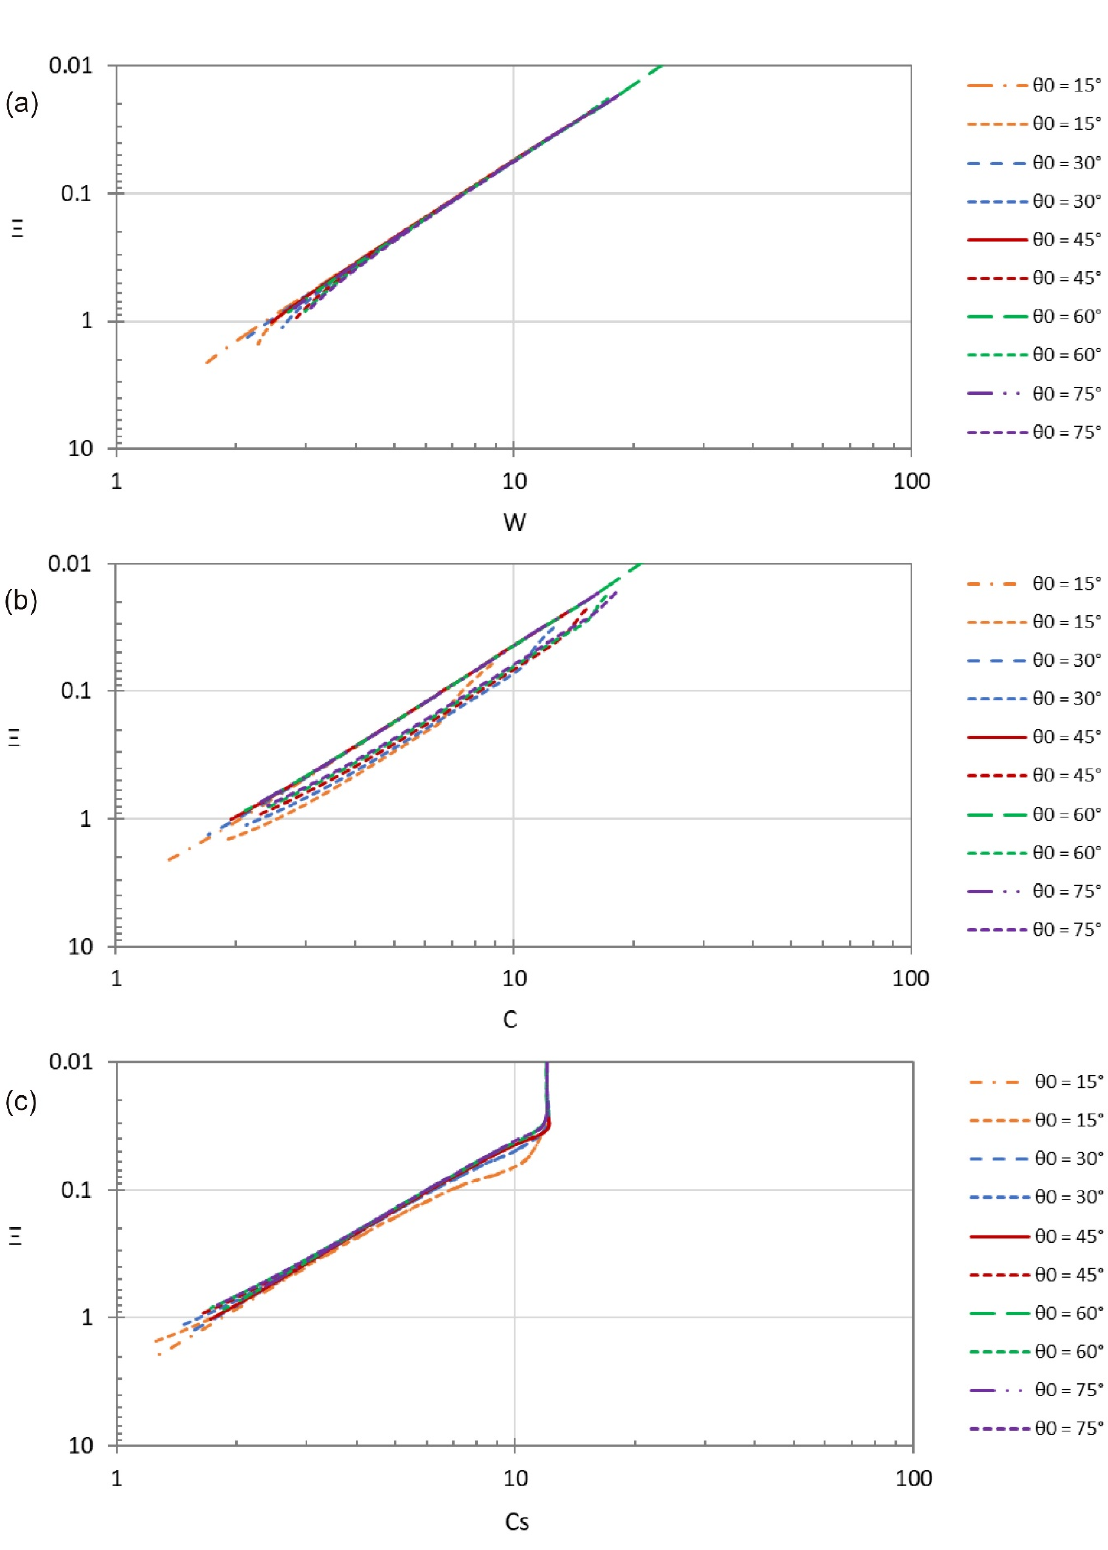
Figure 5. Variation of the normalised ( a ) dimensionless centreline buoyant jet velocity W = ( w m / w 0 ) F 2/3 ; ( b ) centreline concentration C = c m F 2/3 ; and ( c ) bulk concentration C S = c T F 2/3 with respect to the normalised trajectory length Ξ = ( ξ / D ) F − 4/3 for the first and last cycle of air conditioning operation, for the inclination angles examined. The results for the last cycle are shown with same colour as for the first cycle’s, but with lines of the smallest